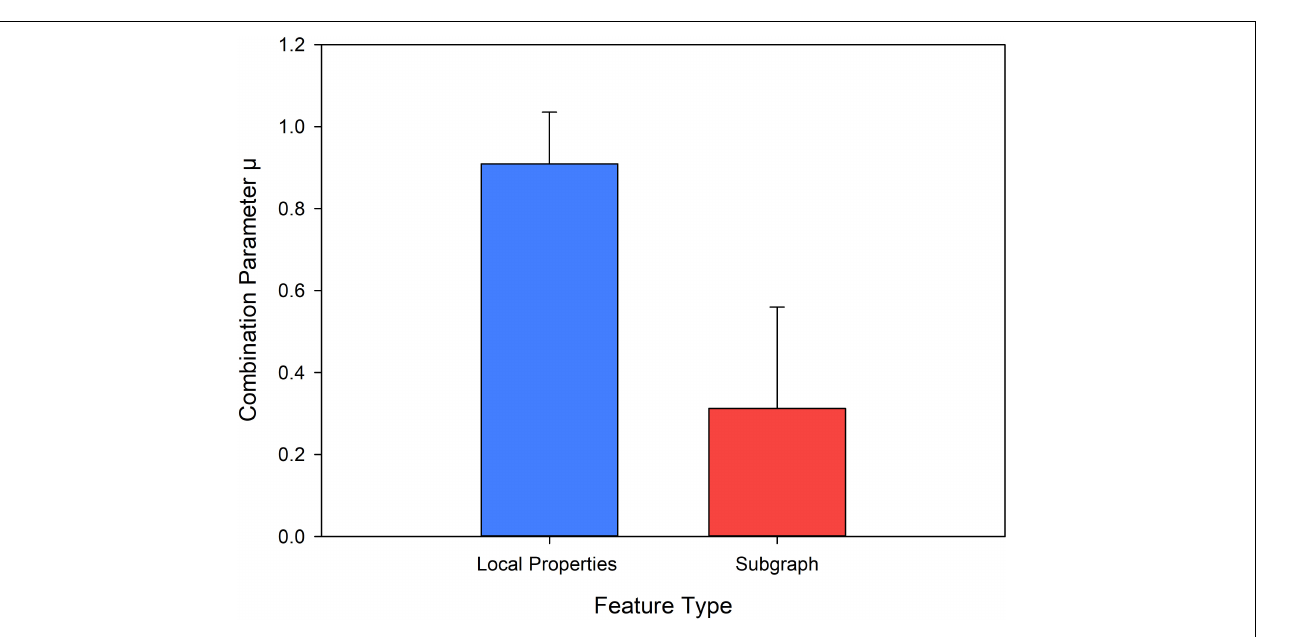
FIGURE 12 | Corresponding combination parameters under different discriminative